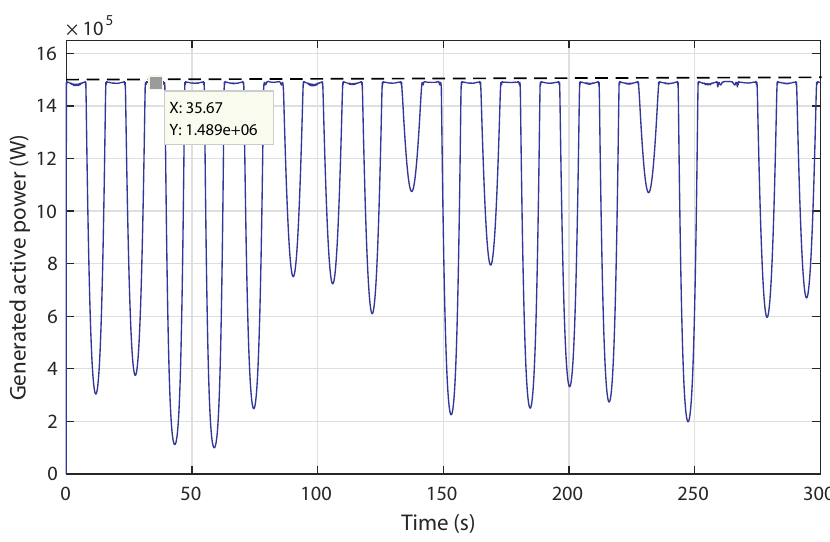
Figure 20. Scenario 2: Generated active power